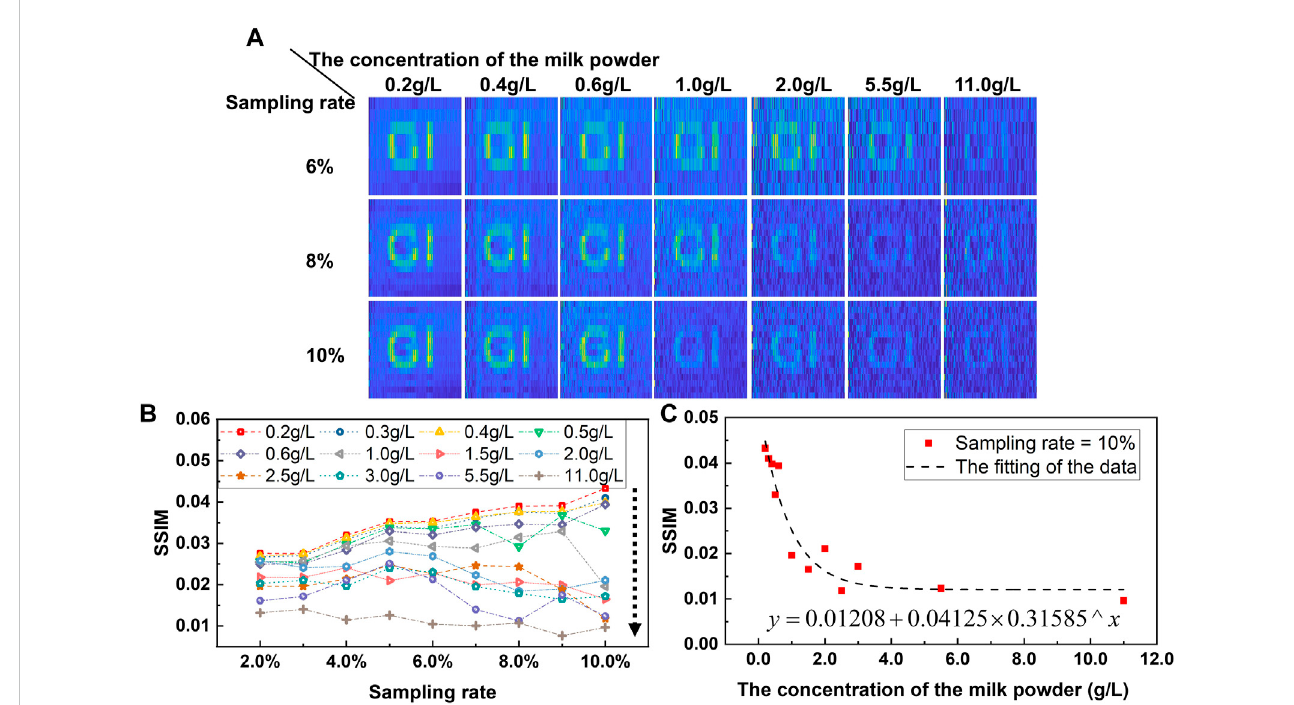
FIGURE 8 (A) Experimental results of laser GI based on Walsh speckle patterns in the turbidity water. (B) SSIM indicator vs sampling rates in the different turbidity water. (C) SSIM indicator vs the concentrations of the milk powder when the sampling rate is